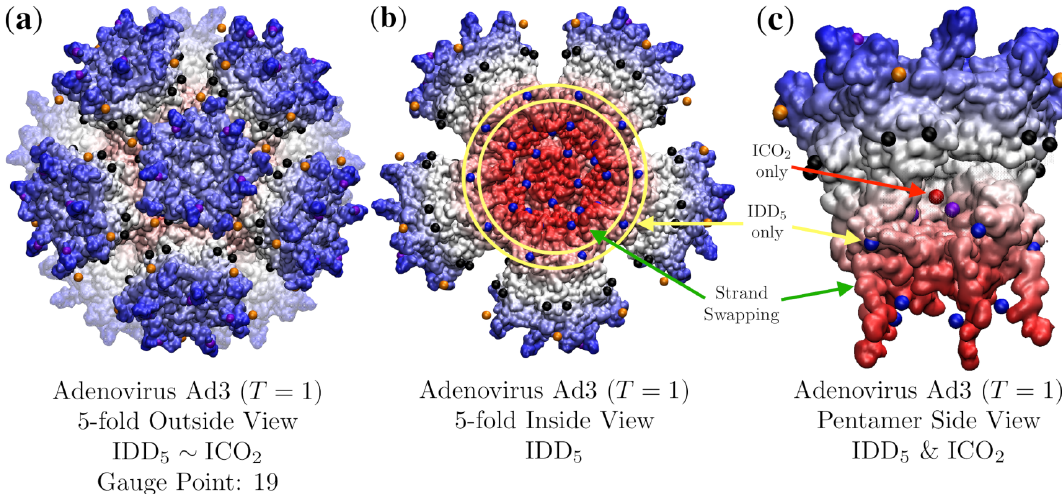
Figure 12. ( a ) Adenovirus Ad3 Dodecahedron is composed of a penton base (Ad3, T = 1, 4aqq [20]) and is best fitted by IDD 5 with an RMSD of 3.7 Å and Gauge Point 19. Ad3 is not equally co-fit by the sister point array ICO 2 . The radial histogram of these sister point arrays appear in Figure 8b. It is noteworthy that the entire point array was used in the fitness algorithm, without any radial cutoff. While the gauge points and interior points agree well with the protein surface, there are several points (orange and black) that float a few angstroms off the surface. ( b ) The interior view of the capsid. Ad3 is stabilized by strand-swapping between neighboring pentamers, which occurs across the 2-fold axes between the IDD base (blue points encircled in yellow) of IDD 5 and the innermost (lowest radial level) points (blue) which sit on the underside of the strand-swapping. ( c ) A side view of one of the pentamer subunits with a section of protein removed to show the interior 5-fold point (red) contained by ICO 2 only and the interior 2-fold points (blue) contained by IDD 5 only. These 2-fold points (blue) provided by IDD 5 only, are situated at the major point of contact between the adjacent pentameric units, above the strand-swapping. As the two sister point arrays are identical except for these points (Figure 8), they are the deciding factors on which RMSD is lower. Here the ICO 2 point (red) is sitting in an empty pocket, making the RMSD 4.9 Å 1.2 Å higher than IDD 5 with an RMSD of 3.7